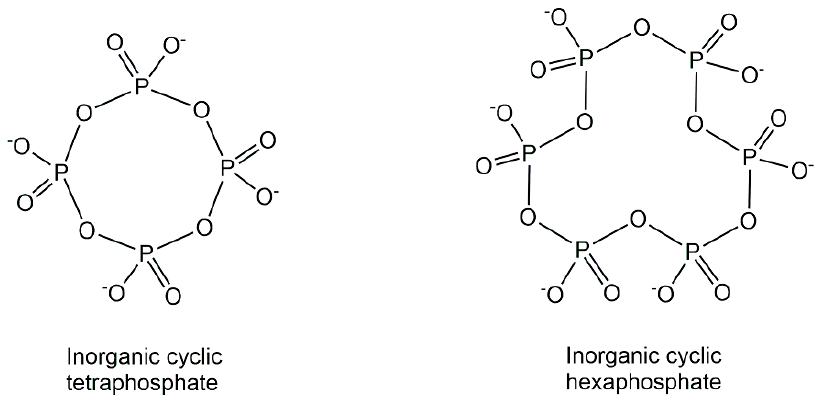
Figure 4. Natural inorganic cyclic tetra-and hexaphosphate structures.